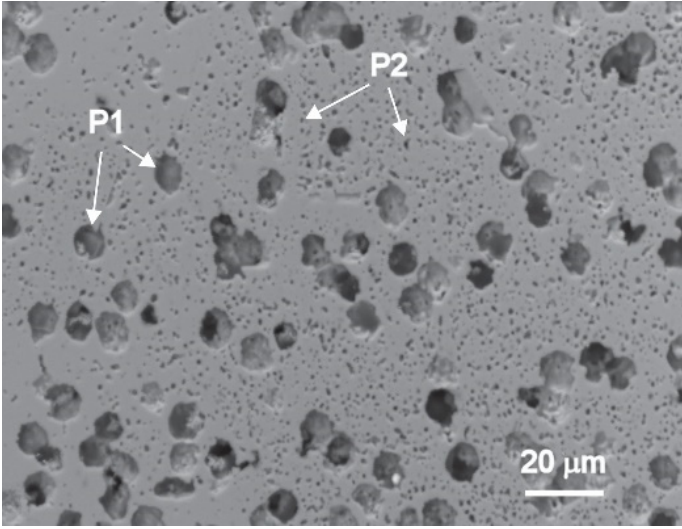
Figure 4. Polished cross-section SEM image of the KNNSr-C ceramic sintered at 1100 °C for 2 h in oxygen.